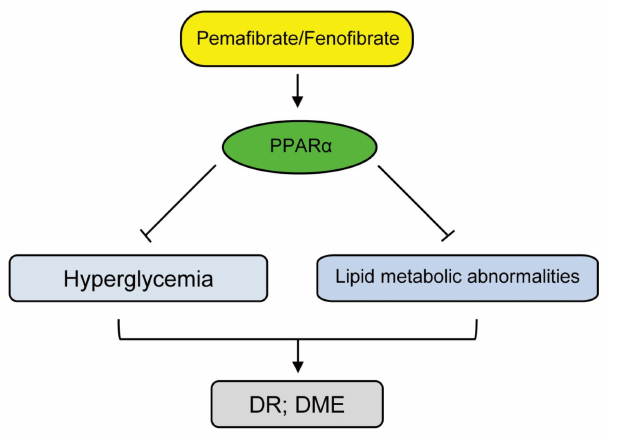
Figure 4. A flowchart of promising treatments for diabetic retinopathy (DR) and diabetic macular edema (DME). PPAR α activation by pemafibrate/fenofibrate is associated with modulating energy homeostasis in hyperglycemia and lipid metabolic abnormalities through the regulation of both lipid and glucose levels. Continuous control of levels of glucose and lipid is available with this promising treatment. DR; diabetic retinopathy, DME; diabetic macular